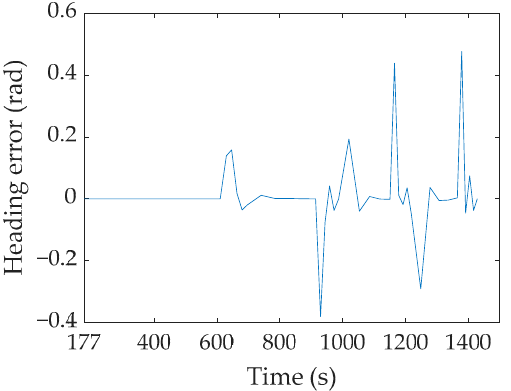
Figure 23. Cross-track heading angle error for the AUV.